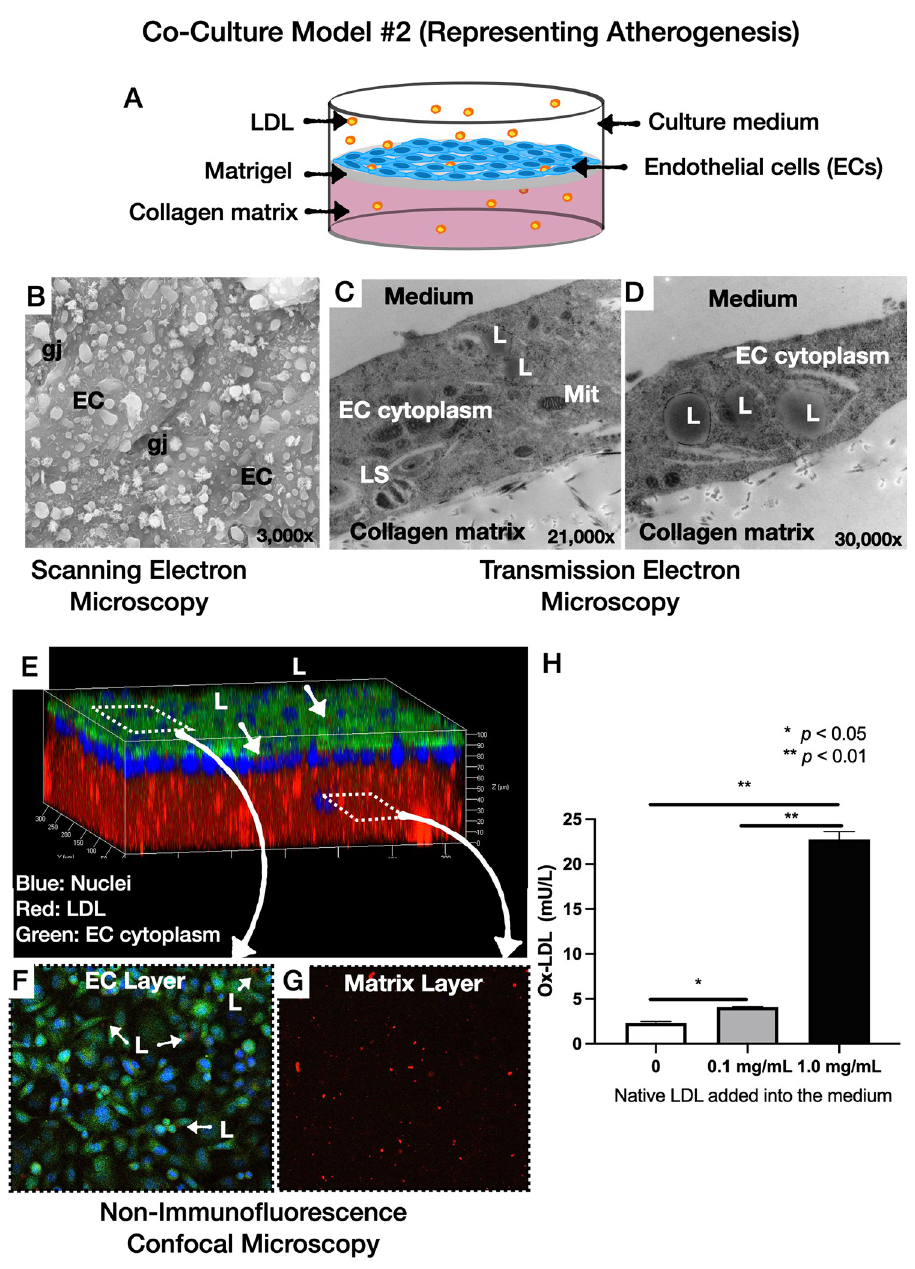
Fig 3. Co-culture model #2 representing atherogenesis. A : Schematic illustration: Addition LDL particles on the monolayer of the HCAECs cultured on top of Matrigel-coated collagen matrix, B : Scanning electron microscopic images, C and D : Transmission electron microscopic images. Note the presence of lipid droplets within the ECs cytoplasm, E, F and G : 3D image of the co-culture by non-immunofluorescence confocal microscopy, showing the transportation of the LDL particles (red) from the medium to the subendothelial space through the pre-stained HCAECs monolayer (green and blue), H : Presence of oxidized LDL in the medium in a native LDL concentration- dependent manner (EC: endothelial cells; gj: gap junctions; Mit: mitochondria; L: low-density lipoproteins; LS: lysosome). � p < 0.05, �� p < 0.01.